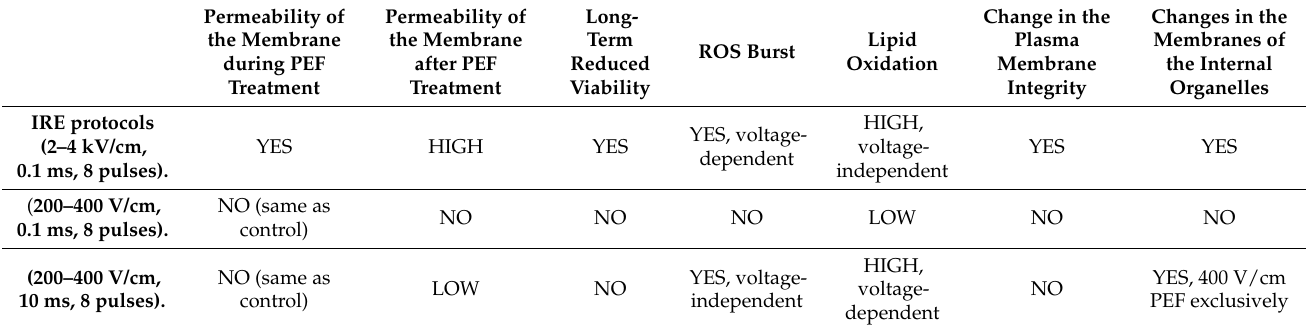
Table 1. Effects of the different PEF protocols on the human melanotic A375 melanoma cells. Permeability of the Membrane